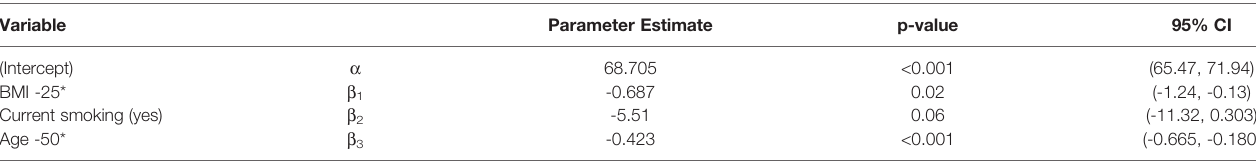
CI, con fi dence interval; BMI, body mass index. R 2 = 0.13. *linear transformation of BMI (minus 25) and Age (minus